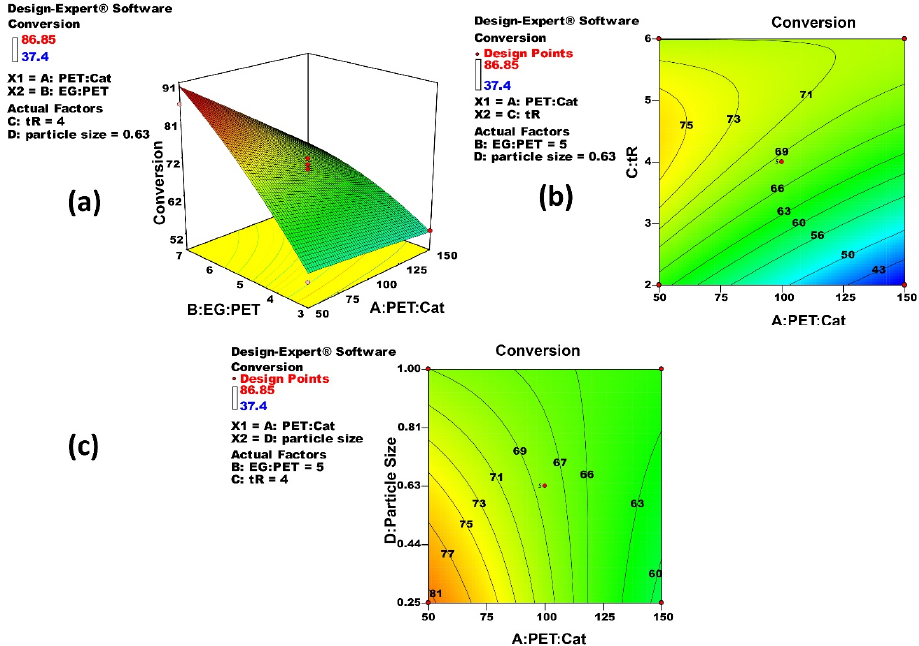
Figure 3. Response surface and contour plots of significant terms from DoE illustrate the performance and behavior of Equation (7) .